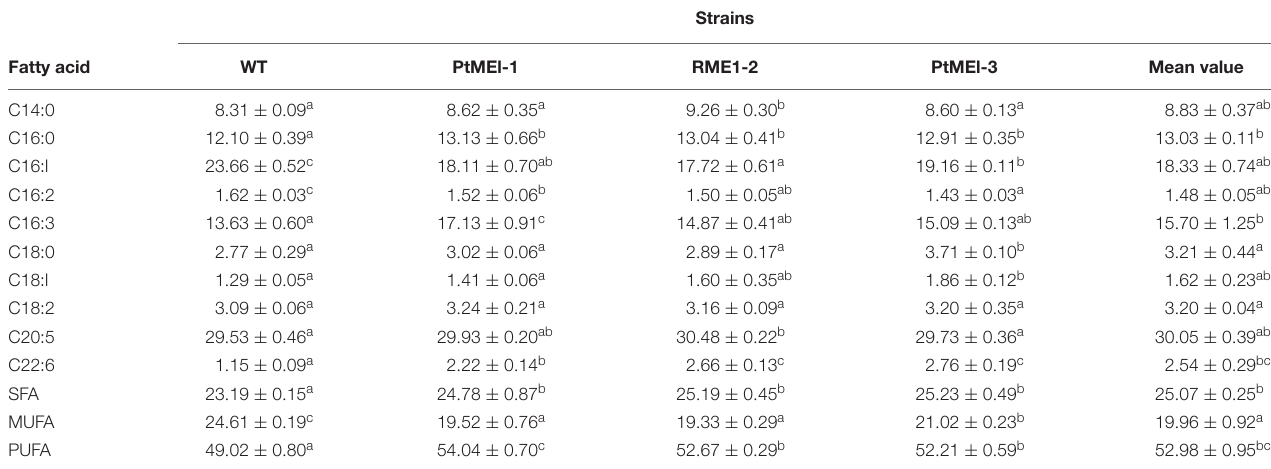
TABLE 2 | Fatty acid composition of the WT strain and the three transformants (% of total fatty acids).